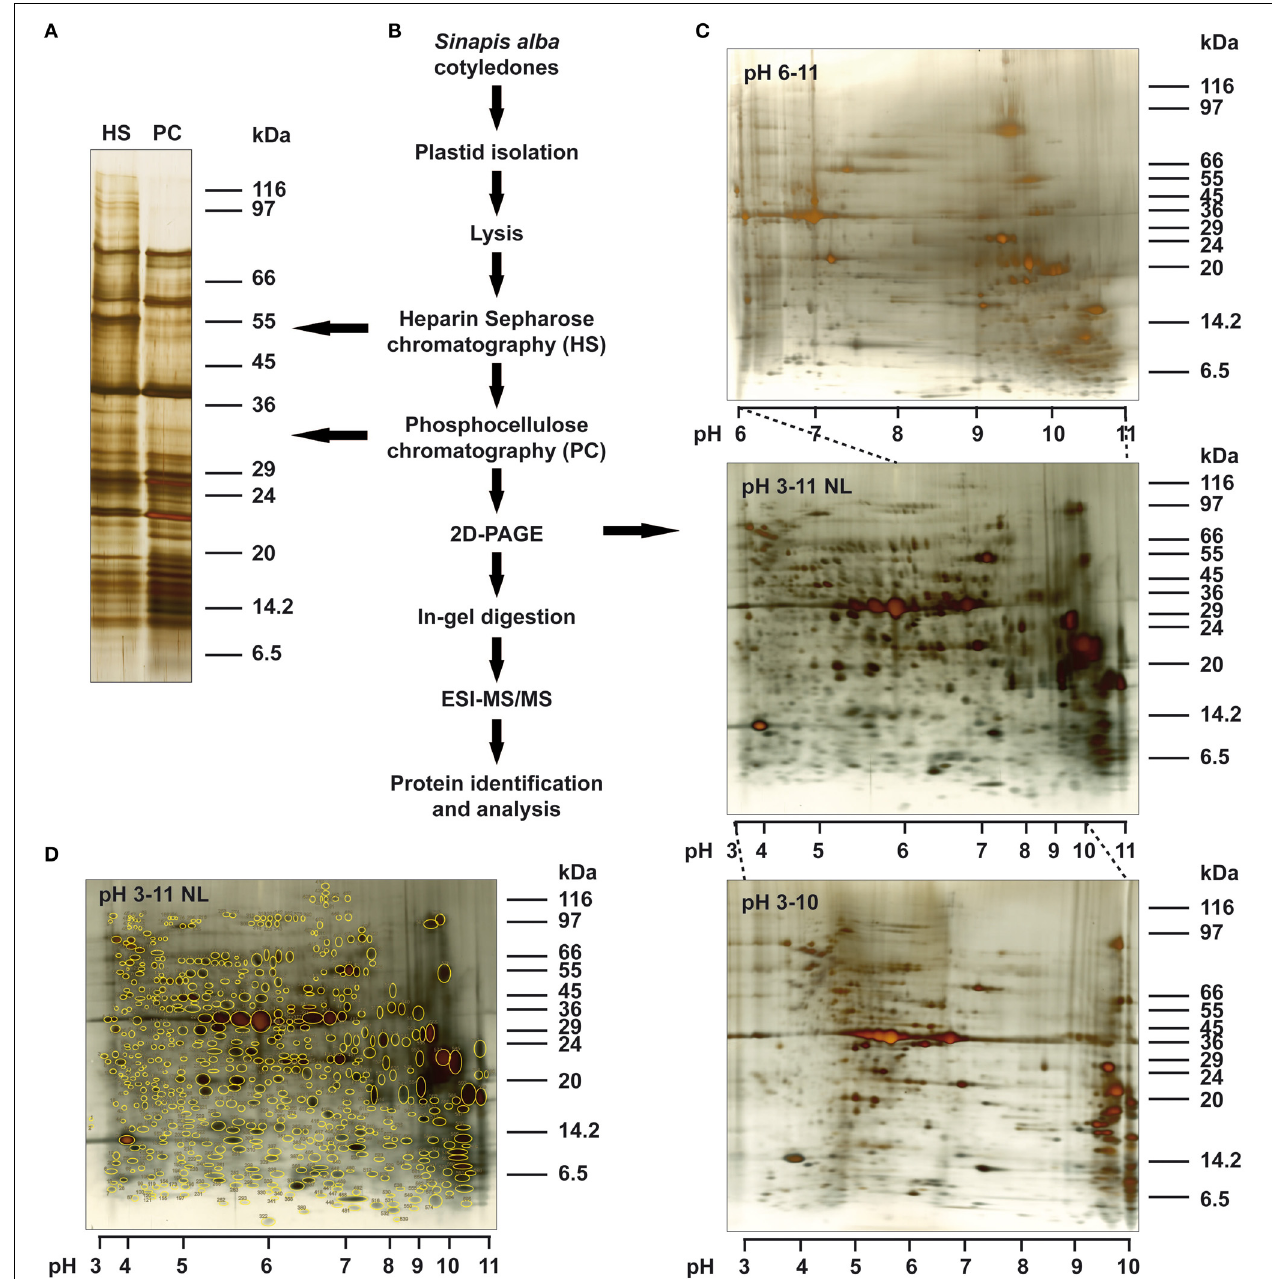
FIGURE 1 | Overview of purification procedure and protein visualization by 2D PAGE. (A) Protein peak fractions after HS and PC chromatography in a silver stained 7–20% SDS polyacrylamide gel. Twenty microgram of protein per lane was separated. Sizes of marker proteins are given in the right margin. (B) Flow chart of the complete protein isolation and identification procedure. Arrowsindicatethepurificationstagesseparatedby1D (A) or2DPAGE (C) . (C) Protein pattern of PC peak fractions in silver stained 7.5–20% SDS acrylamide